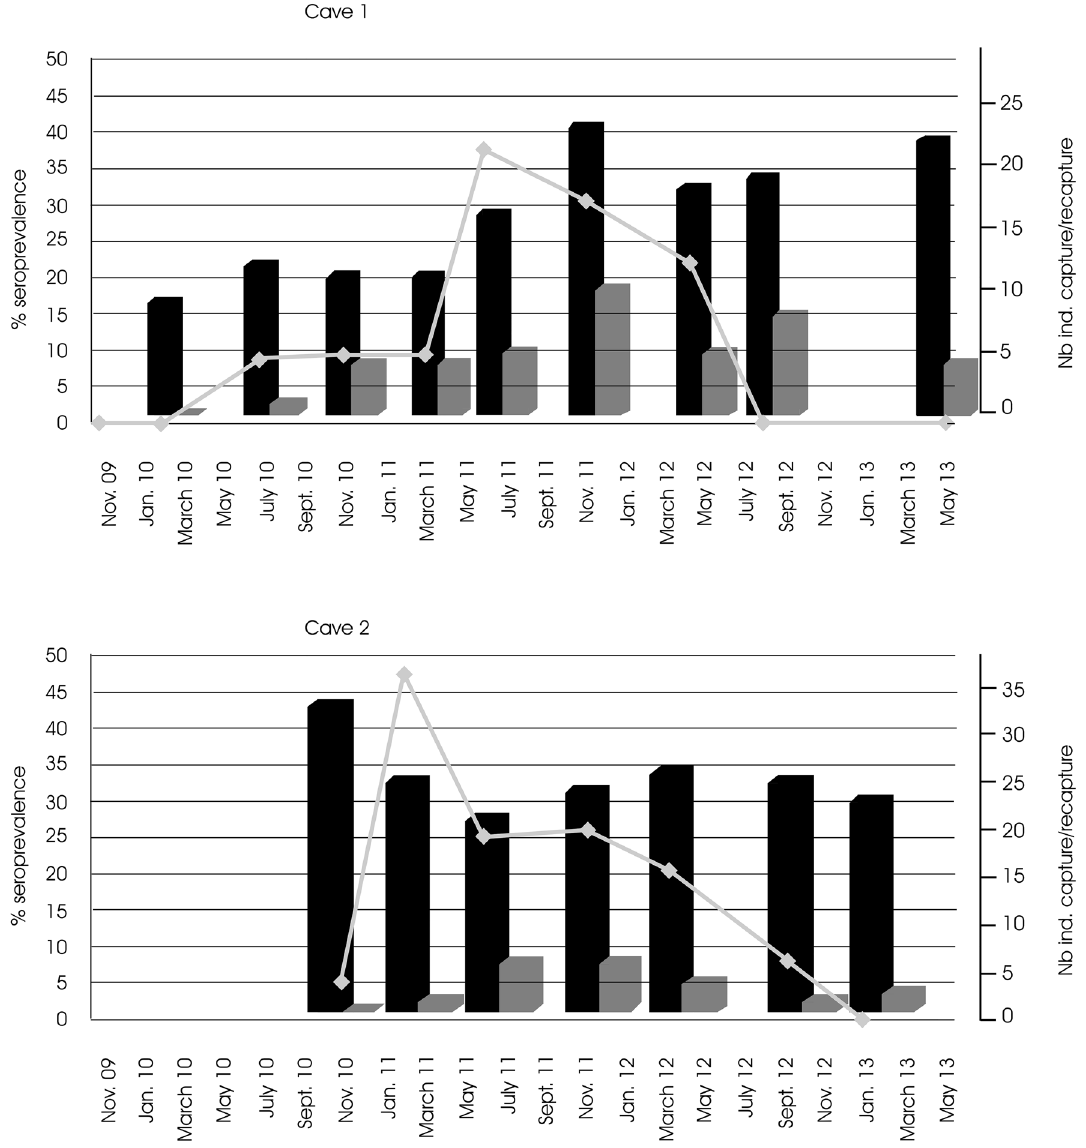
Fig 4. Changes in the percentage of RABV seropositive vampire bats from November 2009 to May 2013 in the two caves and the number of animals captured and recaptured during the same period. Grey line: % of seropositive animals. Black bar: total number of animals captured. Grey bar: number of recaptured